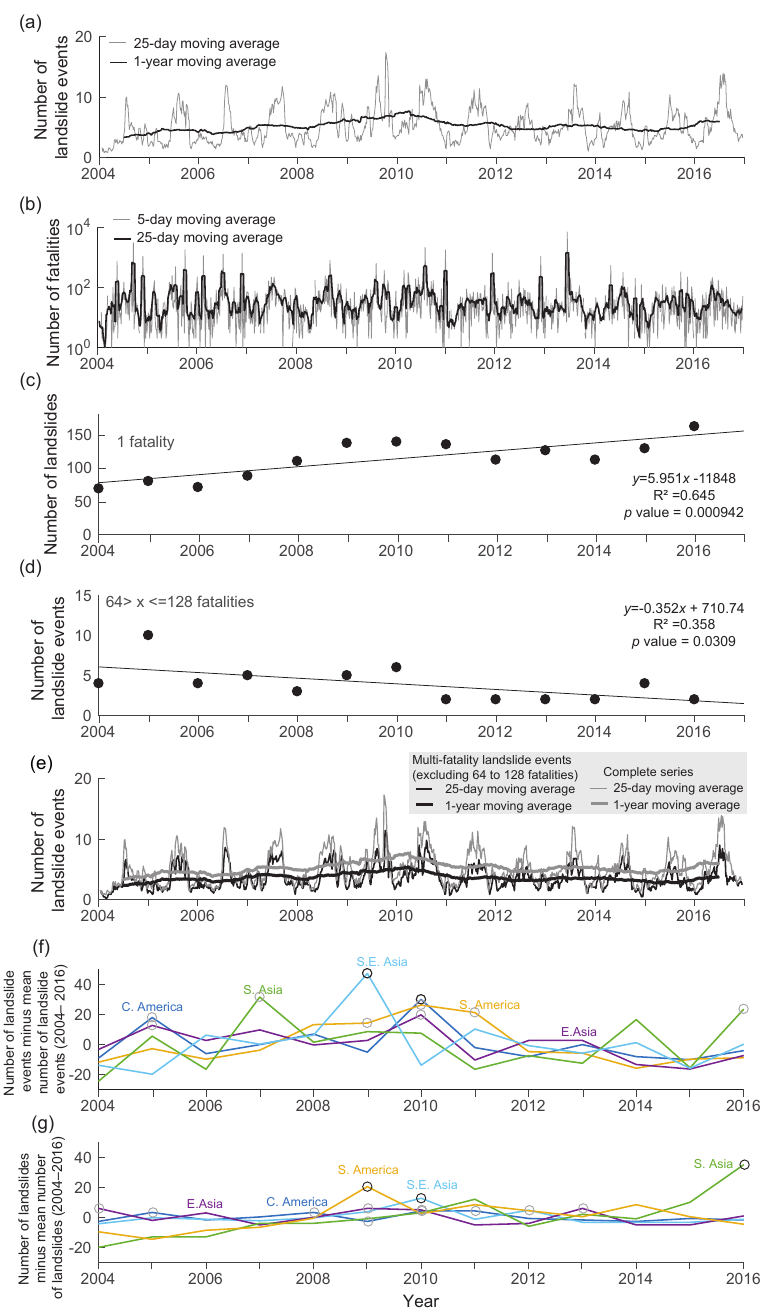
Figure 6. (a) The occurrence of non-seismically triggered landslide events from 2004 to 2016: 25-day and 1-year moving average (see also Fig. 2). (b) The number of fatalities from non-seismically triggered landslide events from 2004 to 2016 by pentad with 25-day moving average. (c) Number of single-fatality landslides 2004 to 2016. (d) Number of landslide events incurring 64 to 128 fatalities per event from 2004 to 2016. (e) Comparison of the complete landslide series (Fig. 6a) and multi-fatality landslide series (excluding the 64- to 128- fatality class). (f) Anomalies in landslide event occurrence by year by geographical region (multi-fatality events). (g) Anomalies in landslide occurrence by year, by geographical region (single-fatality events). Values greater than 1 standard deviation from the mean are shown by a grey circle. Values greater than 2 standard deviations from the mean are shown by a black